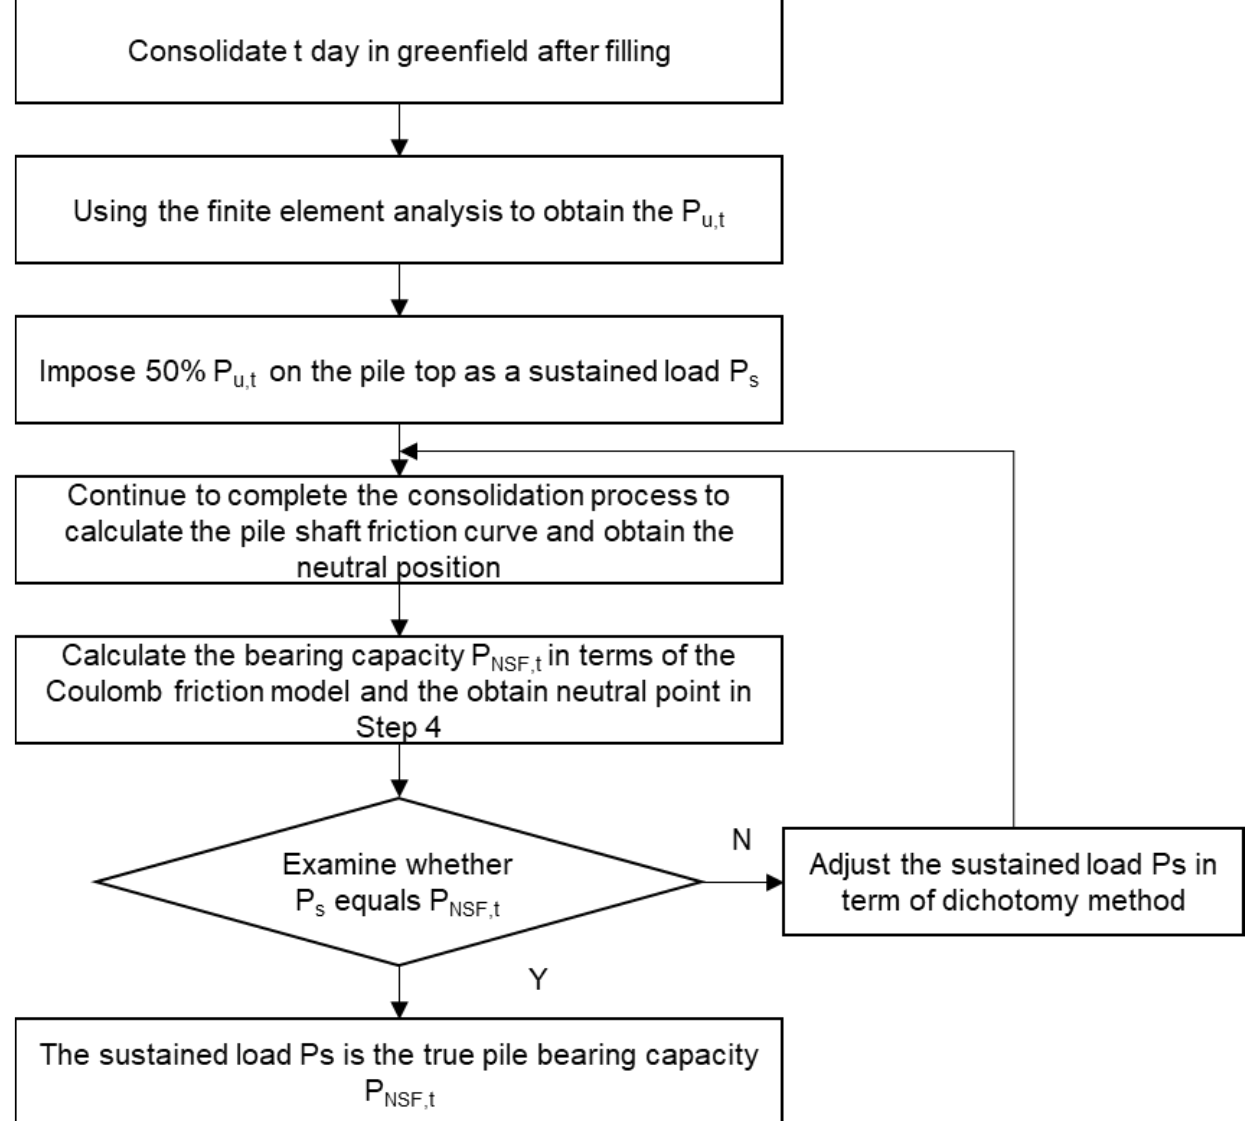
Figure 9. Method for determining the ultimate bearing capacity of pile foundation.